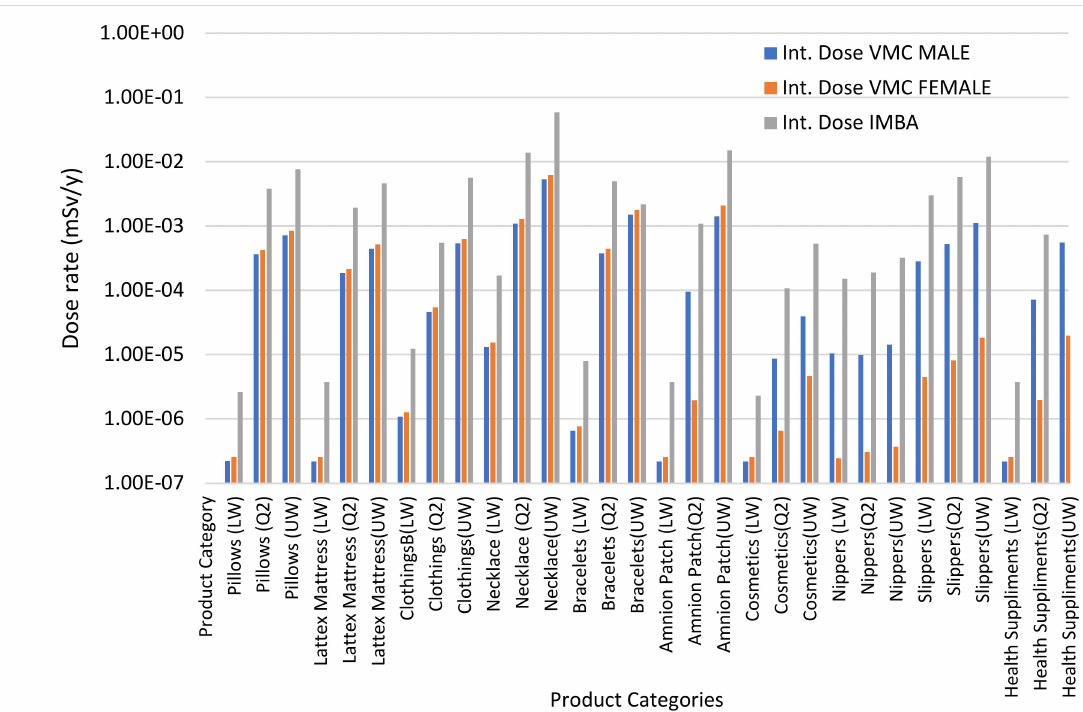
Figure 8. Comparison of internal dose using VMC phantoms and IMBA